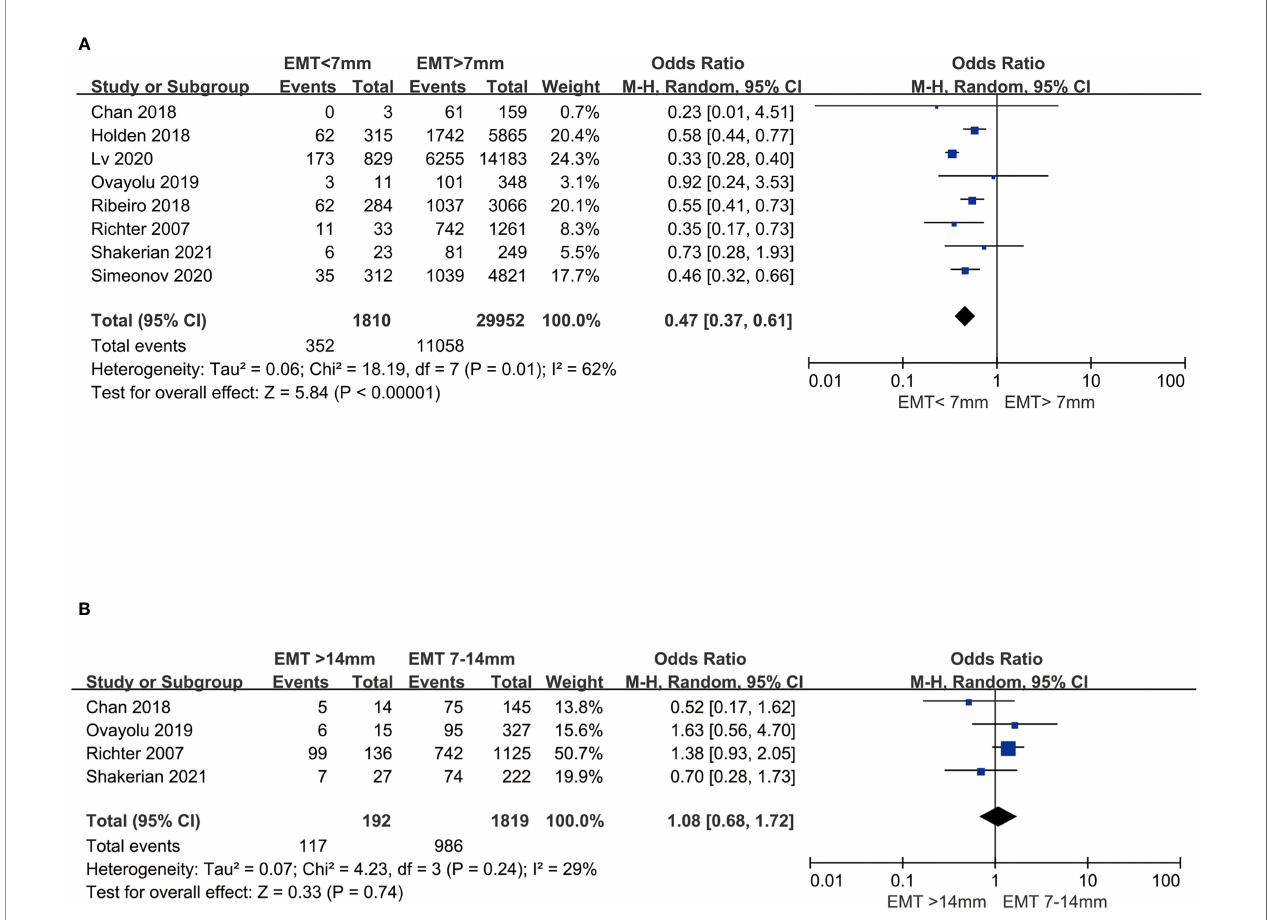
FIGURE 2 | Comparison of LBR between EMT groups in fresh cycles. (A) Comparison between thin endometrium group and non-thin endometrium group. (B) Comparison between thick endometrium group and medium endometrium. LBR, Live birth rate; EMT, Endometrial